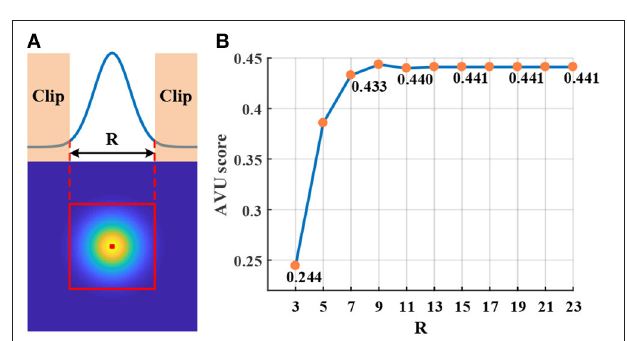
FIGURE 12 | Influence of the connection area: (A) CF clipping; (B) AUC score as R size increases.